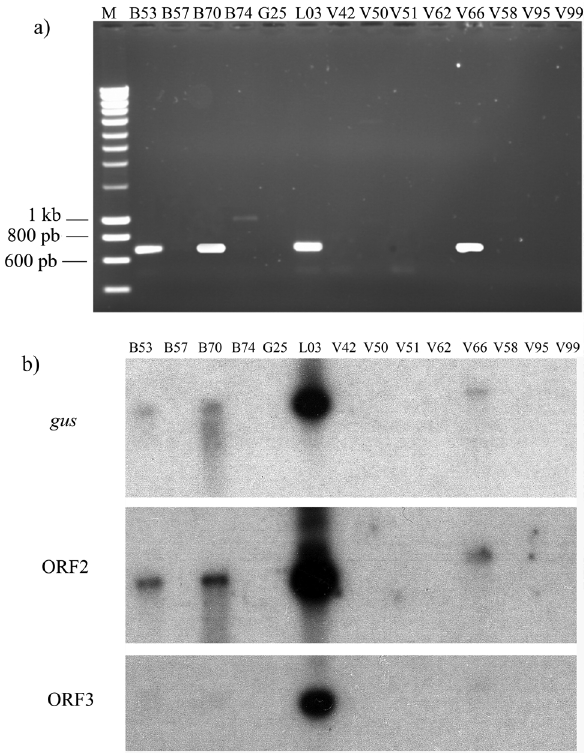
Figure 2 - Genetic analysis of the gus gene environment for strains of Ruminococcus gnavus. A. Agarose gel electrophoresis to analyze the PCR products. Lane M corresponds to the molecular size marker 1kb ladder (Gibco).The other lanes correspond to PCR performed on genomic DNA from 14 R. gnavus strains. The primers used were specific for the gus gene (685bp).B.Southernhybridizationtoidentifythegenomicfragmentscar- rying the gene gus , ORF2 and ORF3. DNA from R. gnavus strains (Table1) was restricted by Eco RV and hybridized with 32 P-labelled gus , ORF2 and ORF3 probes after electrophoresis. One unique Eco RV frag- ment of 5 kb was shown to hybridize to these probes. Previous studies have shown that this fragment comprises these three complete ORFs (Beaud et al. ,